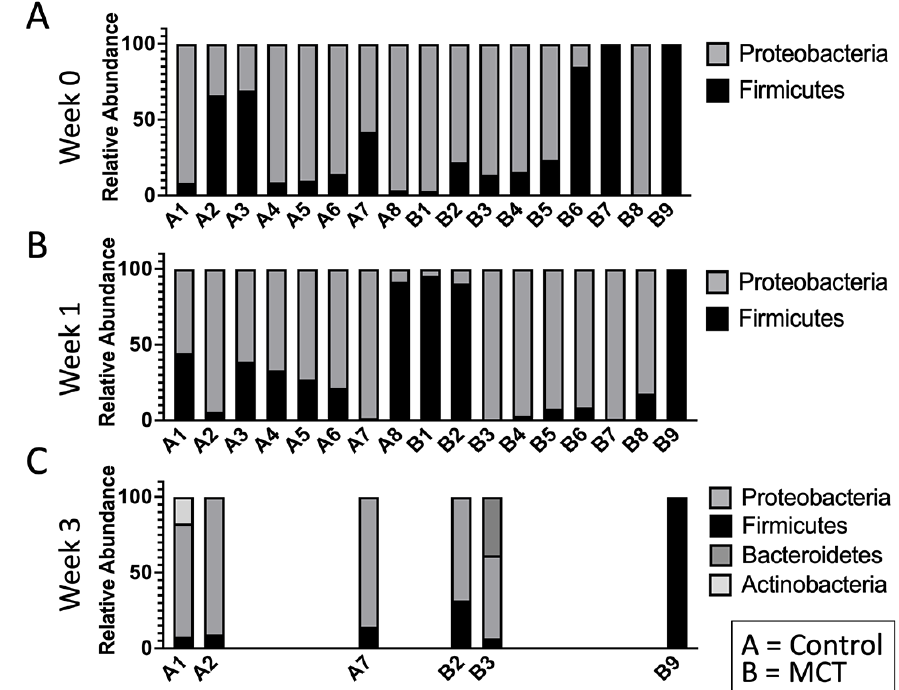
Figure 4. The infant gut microbiota is composed of limited phyla. Phyla were observed in stool bacterial communities over three weeks. ( A ) Week 0 indicates samples collected before supplementation began. ( B ) Week 1 indicates samples collected after one week of MCT supplementation. ( C ) Week 3 indicates samples collected after three weeks of MCT supplementation. Infants A1–A8 belong to the control group. Infants B1–B9 belong to the group that received MCT. Only six infants remained in the study by week 3.